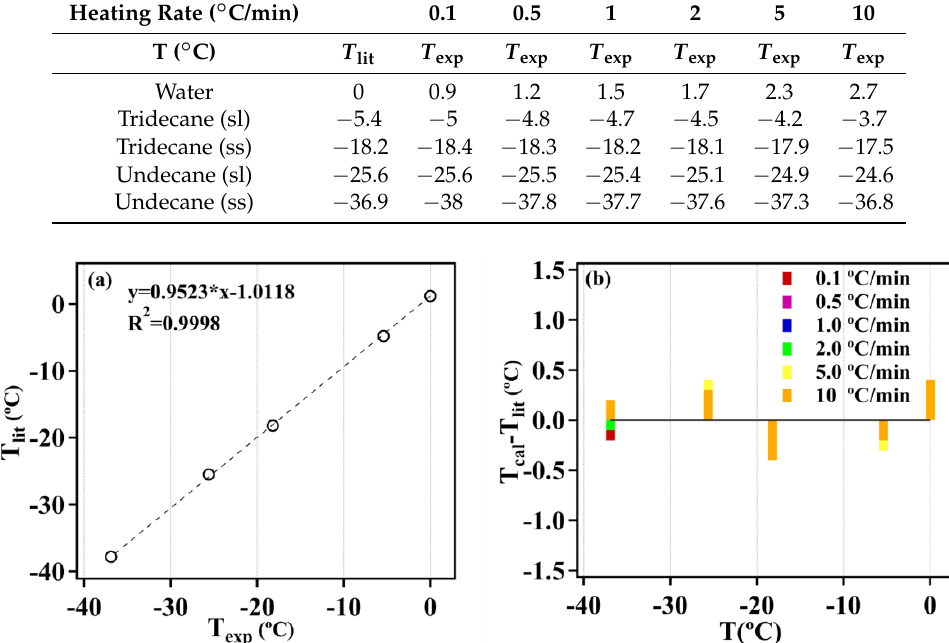
Figure 4. Temperature calibration process (tridecane, undecane, distilled water). ( a ) The experimental transition temperature ( T exp ) plotted with literature phase transition temperatures ( T lit ) with a heating rate of 10 °C/min; ( b ) remaining temperature uncertainties between temperature after calibration T cal − T lit . Table 1. Literature ( T lit ) phase transition point and experimentally determined phase transition temperatures ( T exp ) at different heating rates as shown in Figure 4a.